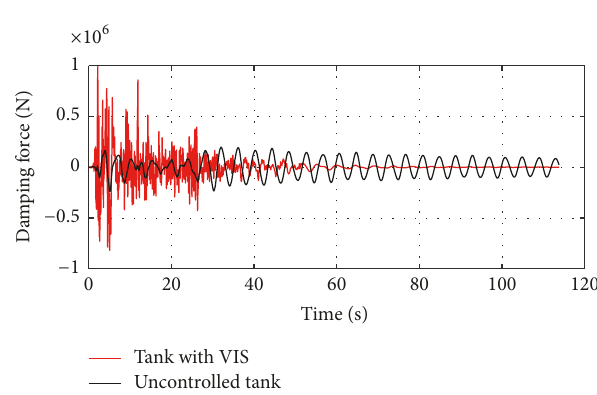
Figure 19: Output forces of the tank with the VIS and the uncontrolled tank under the excitation of the El Centro earthquake.